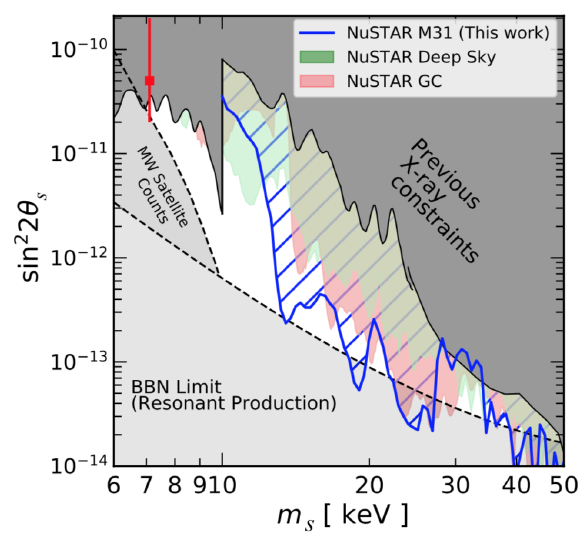
Figure 1: Constraints on sterile neutrino dark matter. Figure taken from [ 8 ] . The colored and gray regions show limits from X-ray searches, while the medium gray region on the left labeled “MW Satellite Counts” is based on structure formation ar- guments [ 9 ] . The region labeled “BBN Limit (Resonant Production)” is disfavored by BBN constraints on the lepton asymmetry if the latter is invoked to enhance sterile neutrino production. The red dot with an error bar indicates the parameters corre- sponding to the sterile neutrino explanation of the 3.5 keV line [ 10,11 ]